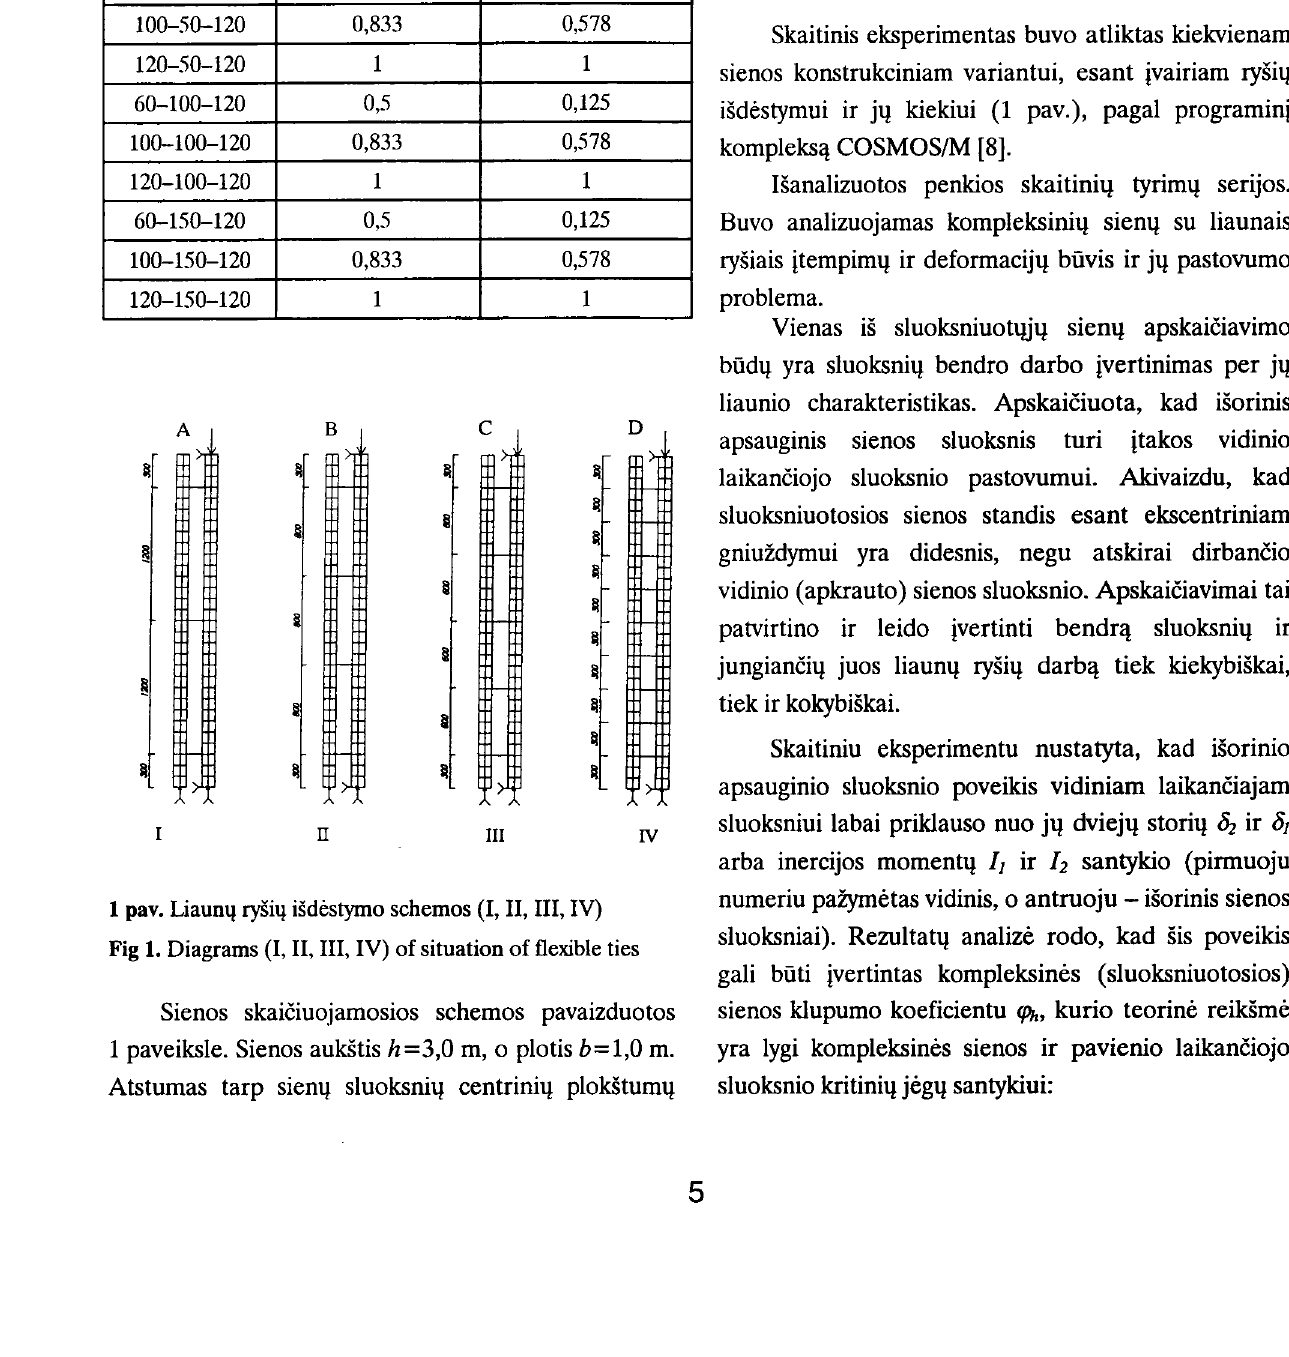
Table 1. Geometrical characteristics of cross-sectional